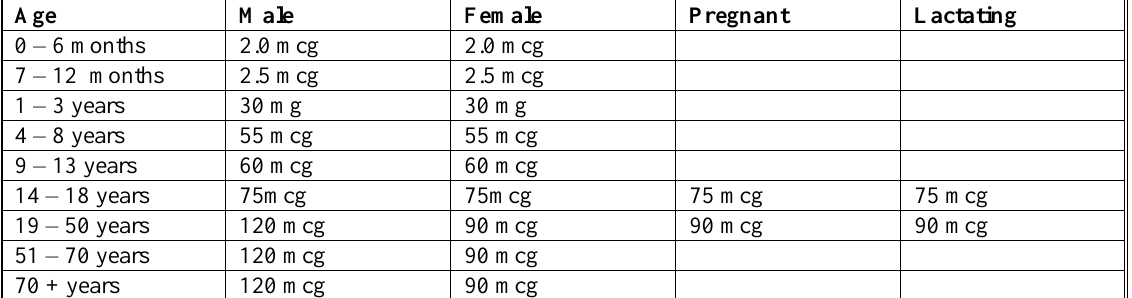
Table 3. Amount of vitamin K needed in different groups of people (65)